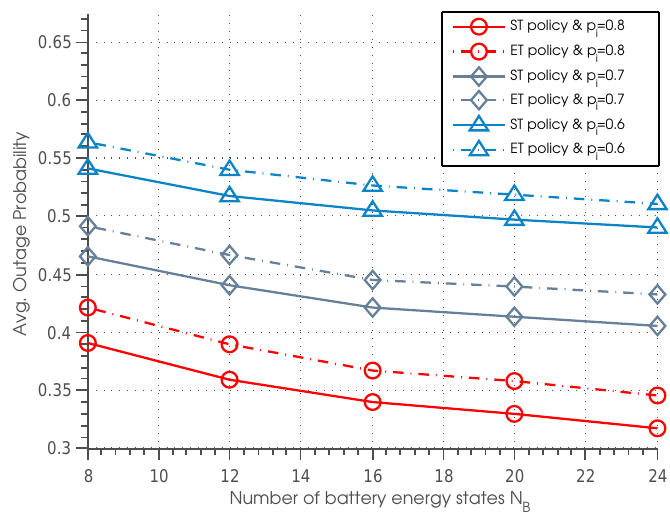
Figure 8. Average outage probability vs. the number of battery energy